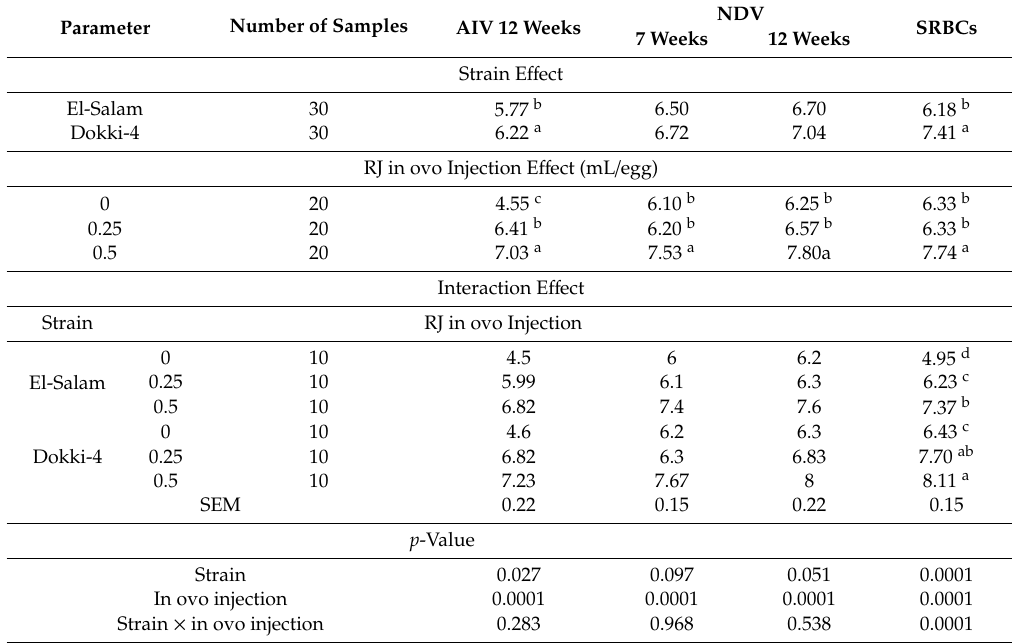
Table 5. E ff ect of in ovo injection of royal jelly (RJ) at two levels (0.25, 0.5 mL / egg) on Antibody titre against AIV, NDV and SRBCs of two chicken strains (El-Salam, Dokki-4) as compared to counterpart control (0 mL / egg) and the interaction of strain and treatment